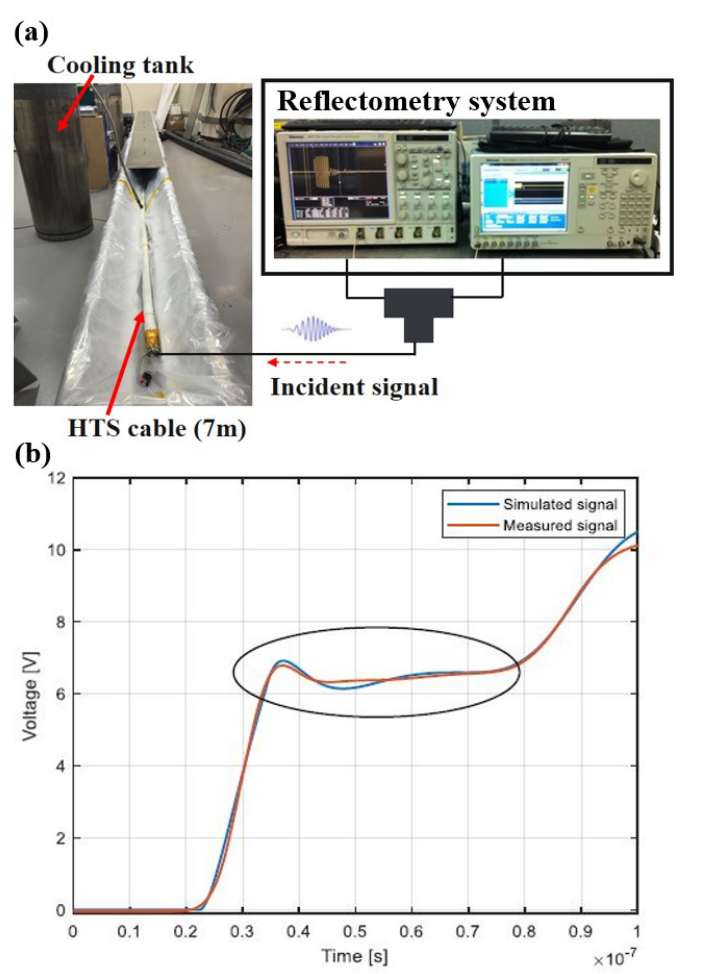
Figure 7. High temperature superconducting (HTS) cable modeling. ( a ) Experimental setup ( b ) Experimental resulets of modeling HTS